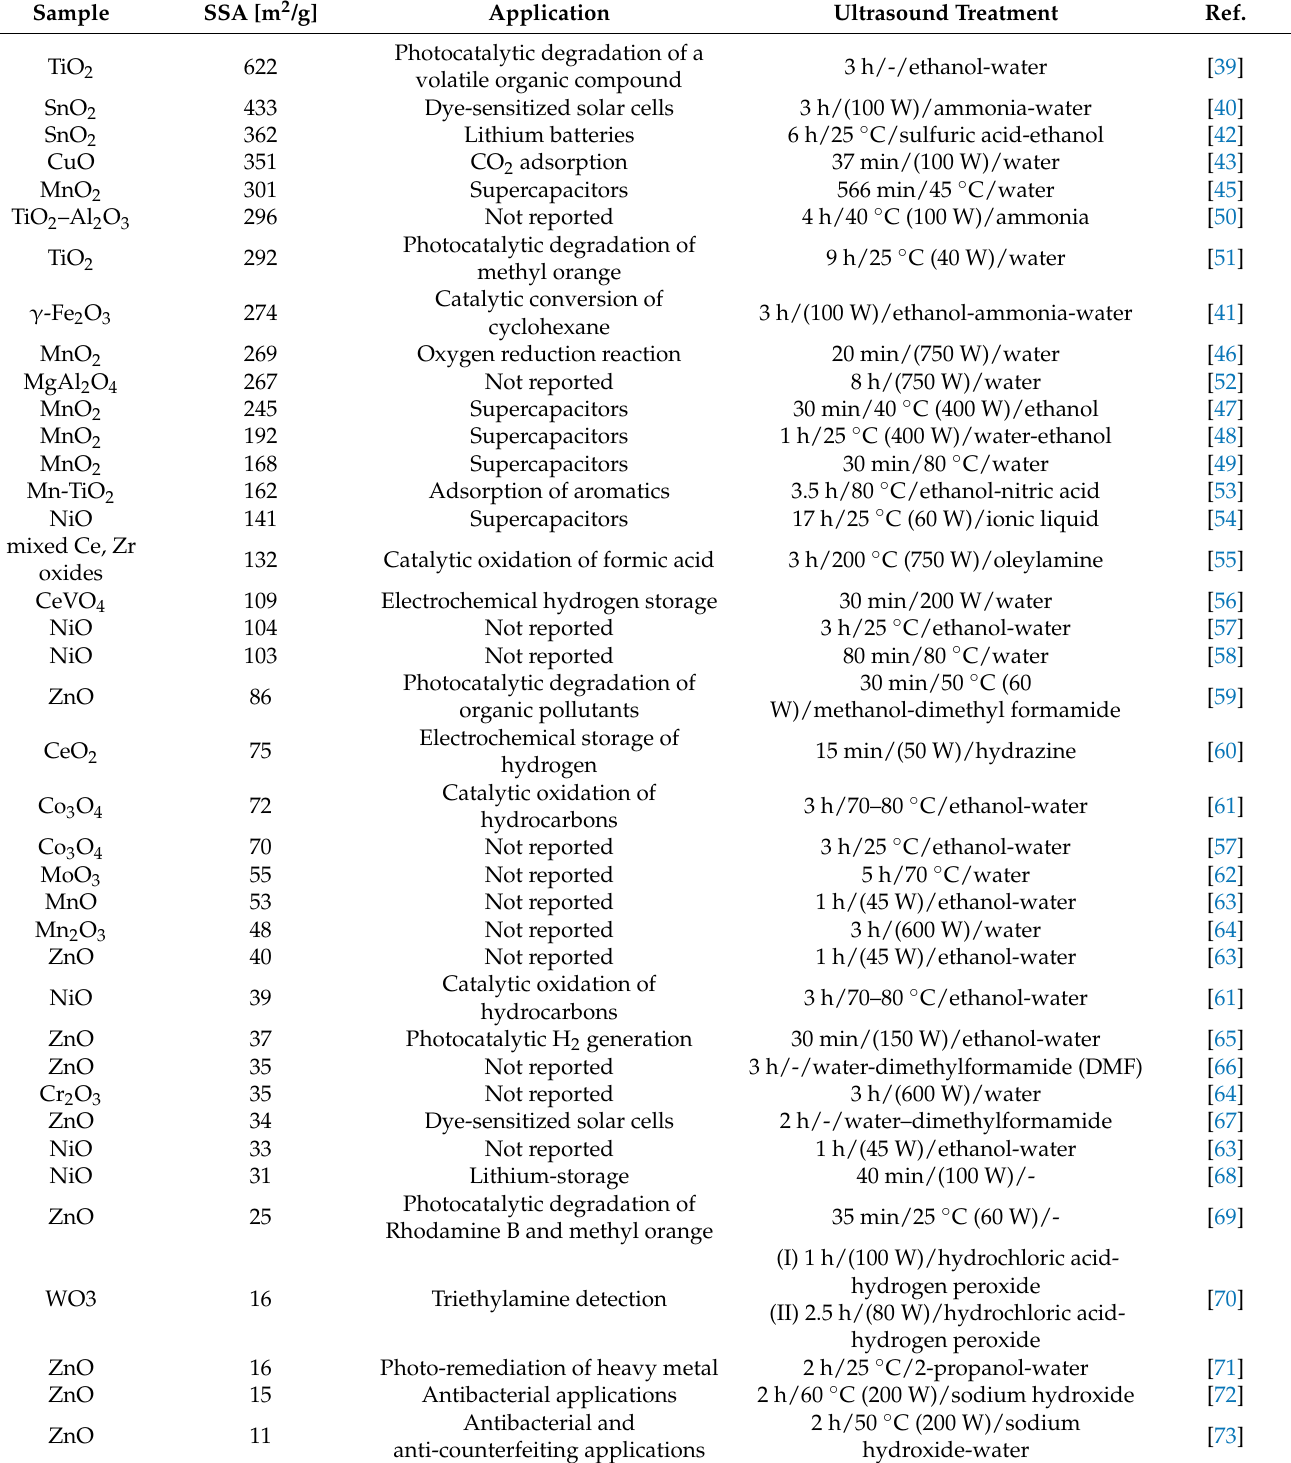
Table 2. Porous metal oxides obtained via sonochemical-assisted